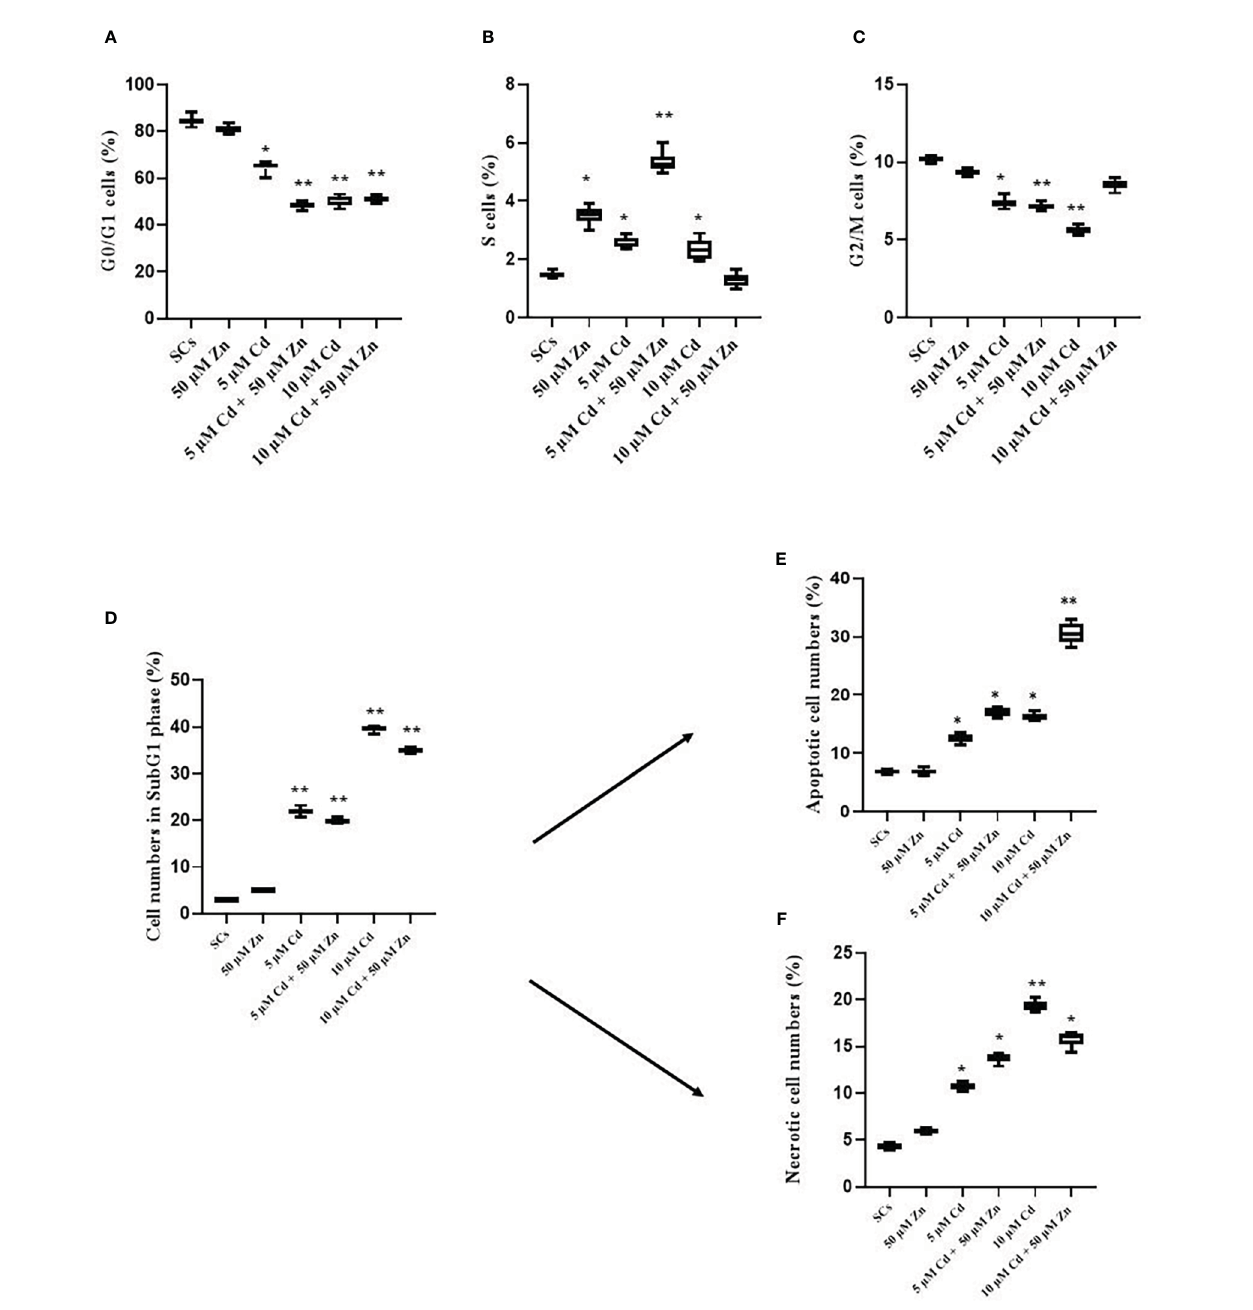
FIGURE 2 Cell cycle progression, apoptosis, and necrosis. Percentage of cells in G 0 /G 1 (A) , S (B) , and G 2 /M (C) and sub-G 1 phase (D) in the absence (unexposed- control group, SCs) or presence of 5 or 10 µM CdCl 2 and/or 50 µM ZnCl 2 for 48 h. Percentage of apoptotic (E) and necrotic (F) cells in the sub-G 1 phase in the absence (unexposed-control group, SCs) or presence of 5 or 10 µM CdCl 2 and/or 50 µM ZnCl 2 for 48 h. Data presented as the mean ± SEM (* p < 0.05 and ** p < 0.001 vs . SCs of three independent experiments, each performed in